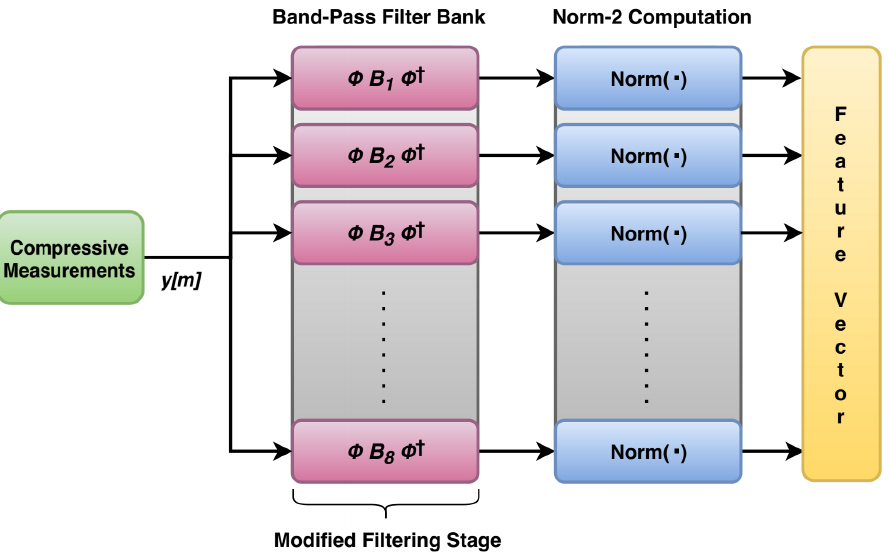
Figure 7. Method used for extracting features from compressive measurements.